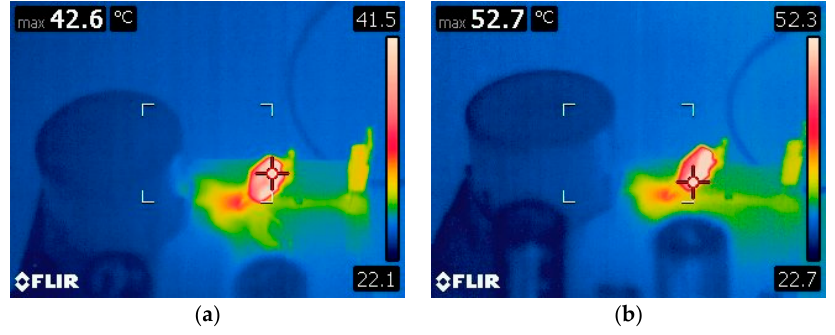
Figure 13. Thermal images at 250 W/m 2 when ( a ) P&O and ( b ) IC are used.